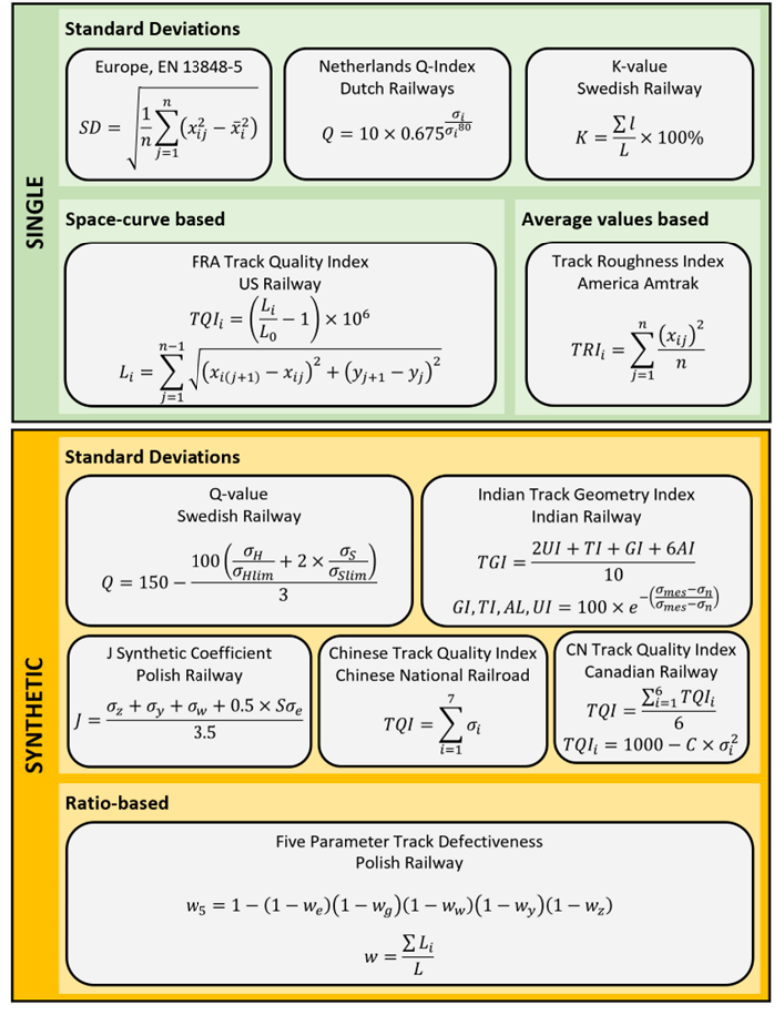
Figure 6. Overview of existing TQIs.